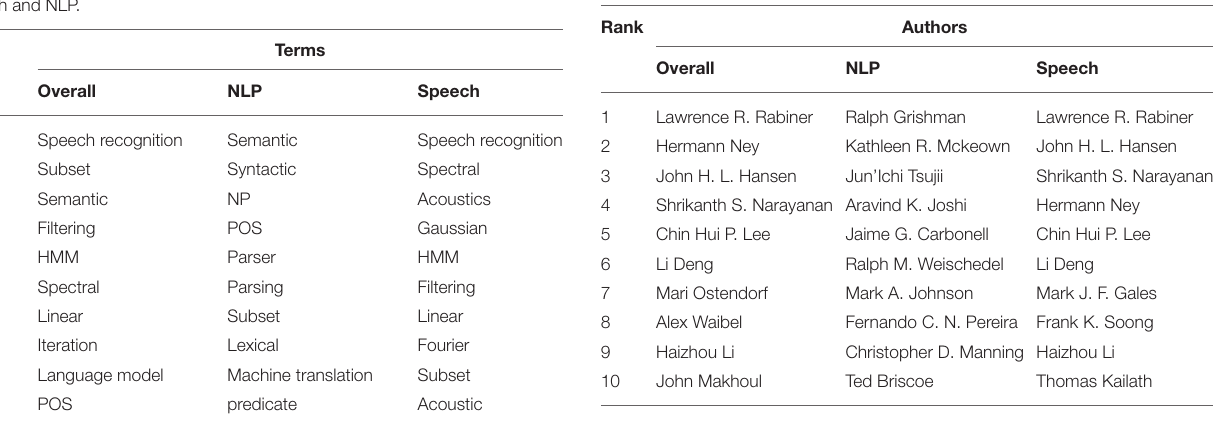
TABLE 5 | Global ranking of authors overall and separately for Speech and